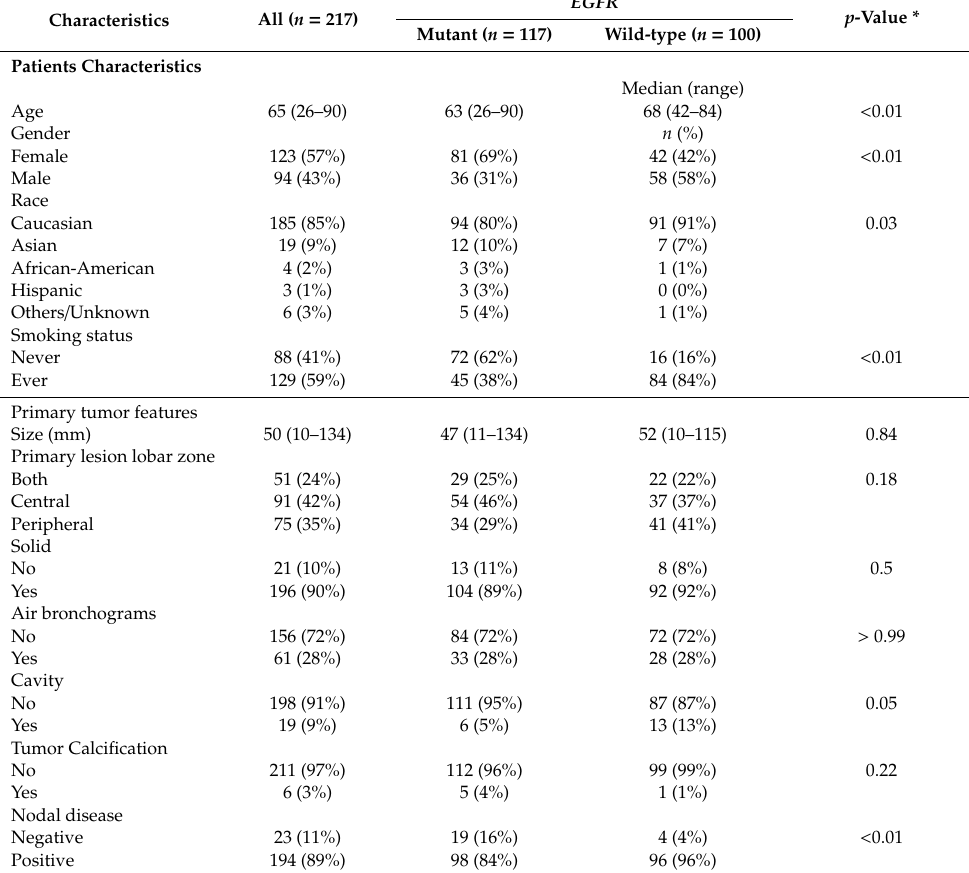
Table 1. Patients characteristics, tumor genotypes, and imaging features among all patients ( n = 217).